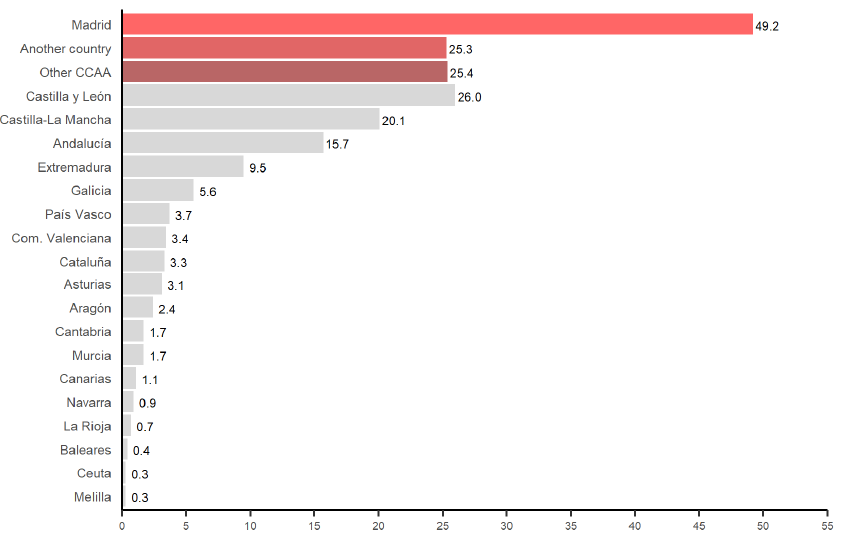
Figure 3. Distribution by autonomous communities of the percentage of allochthonous residents—those registered as living in Madrid born in other autonomous communities. Compiled by the authors based on data from the Permanent Municipal Register of the National Institute of Statistics, updated as of 1 January 2021 [50].